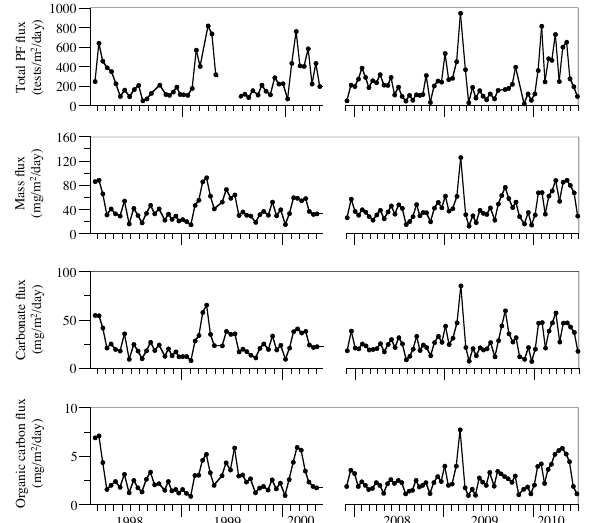
Figure 2. Temporal changes in total planktonic foraminifera flux and mass, carbonate, and organic carbon fluxes at 1500m depth over the 6-year study period.